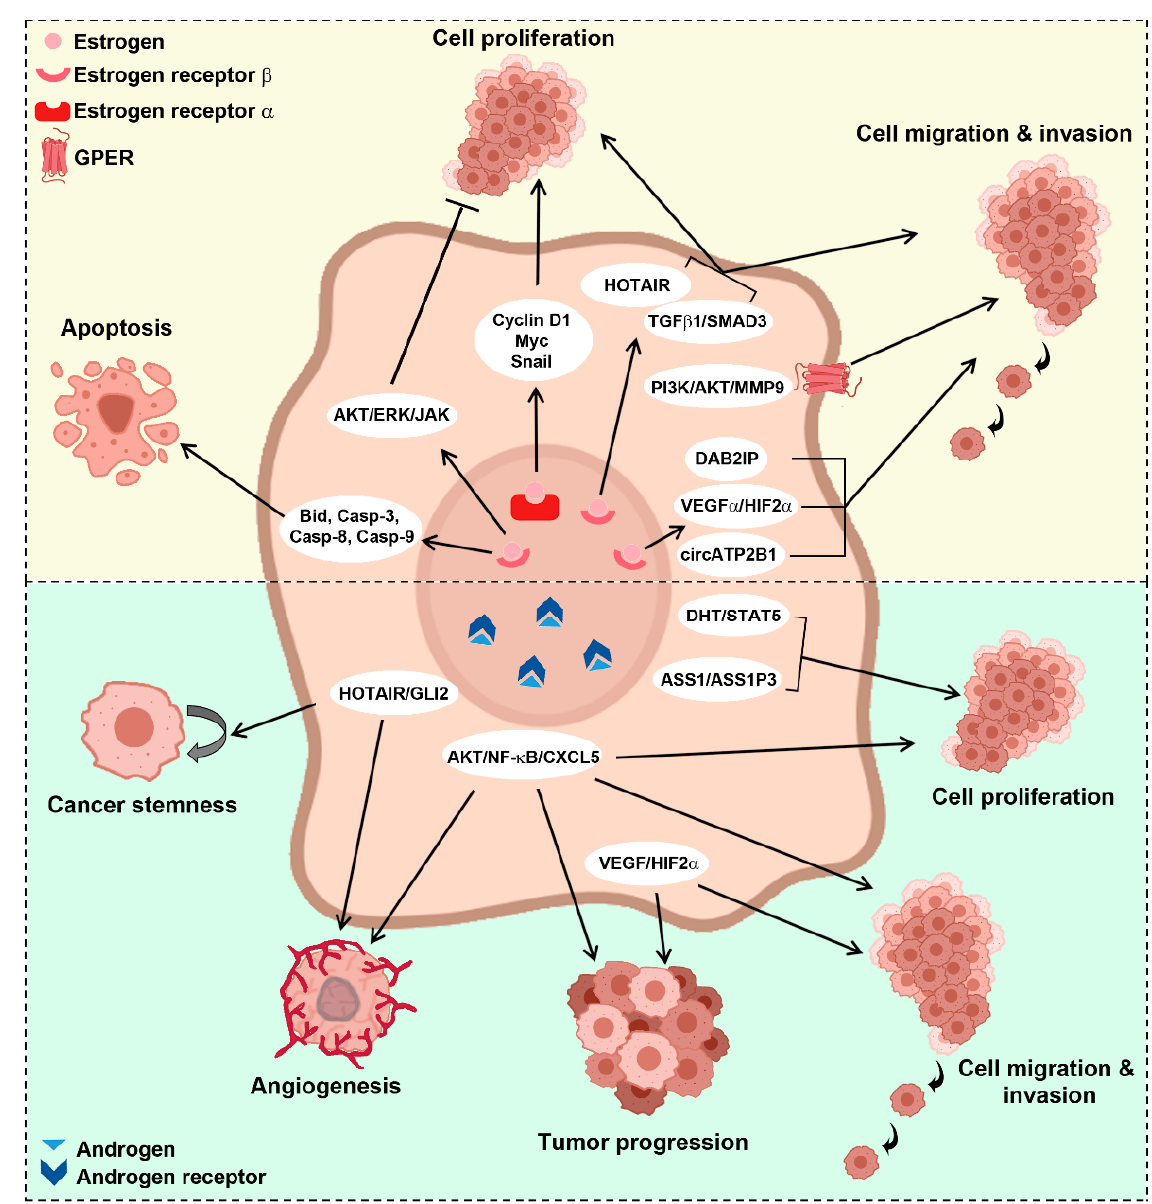
Figure 2. Sex hormone pathways involved in kidney cancer. AKT: protein kinase B; ERK: extracellular signal-regulated kinase; JAK: Janus kinase; TGF β 1: transforming growth factor β 1; SMAD3: small mother against decapentaplegic homolog 3; DAB2IP: disabled homolog 2-interacting protein; VEGF α : vascular endothelial growth factor α ; HIF2 α : hypoxia-induced factor 2 α ; PI3K: phosphoinositide 3-kinase; GLI2: GLI Family Zinc Finger 2; ASS1: argininosuccinate synthase 1; ASS1P3: ASS1 pseudogene 3; DHT: dihydrotestosterone; STAT5: signal transducer and activator of transcription 5; GPER: G protein coupled estrogen receptor; MMP9: matrix metallopeptidase 9; HOTAIR: HOX transcript antisense RNA; NF- κ B: nuclear factor kappa-light-chain-enhancer of activated B cells; CXCL5: C-X-C motif chemokine 5; Bid: BH3 interacting-domain death agonist; Casp-3, -8, -9: caspase-3, -6, -9.